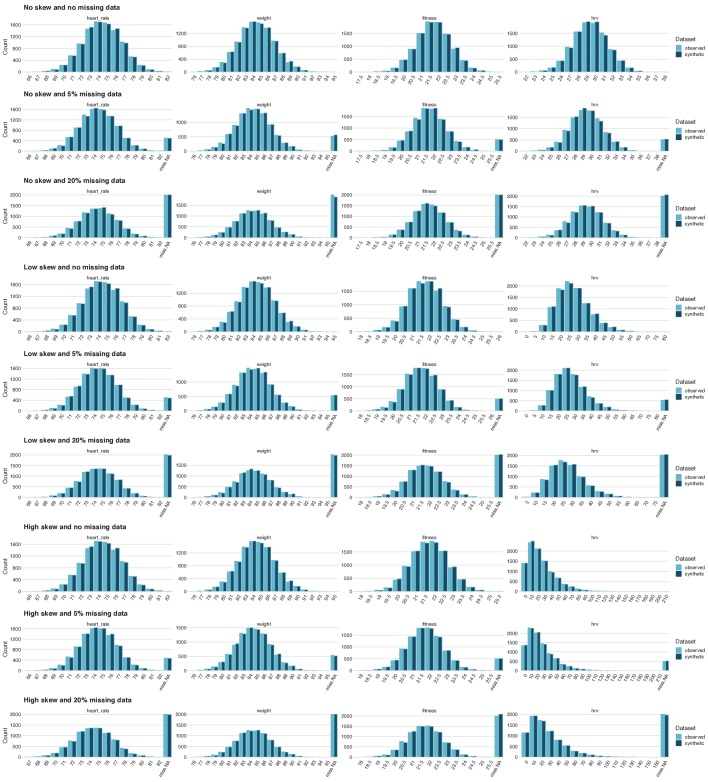
General utility of nine simulated datasets with 10,000 cases.Datasets varied on the shape of the distribution of heart rate variability (HRV) and the percentage of missing data.